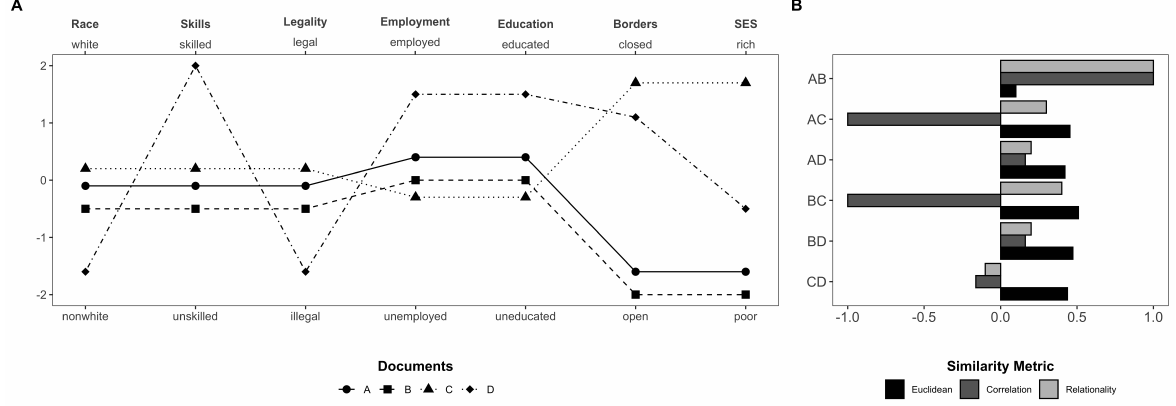
Figure 2: ( A ) Documents and ( B ) associated pairwise similarities across seven semantic direction CMDs concerning immigration. Note : Panel A shows semantic direction CMDs from a political document corpus from four hypothetical documents. Panel B reports each pairwise Euclidean distance (standardized by the maximum possible distance, 10.58301), Pearson correlation, and